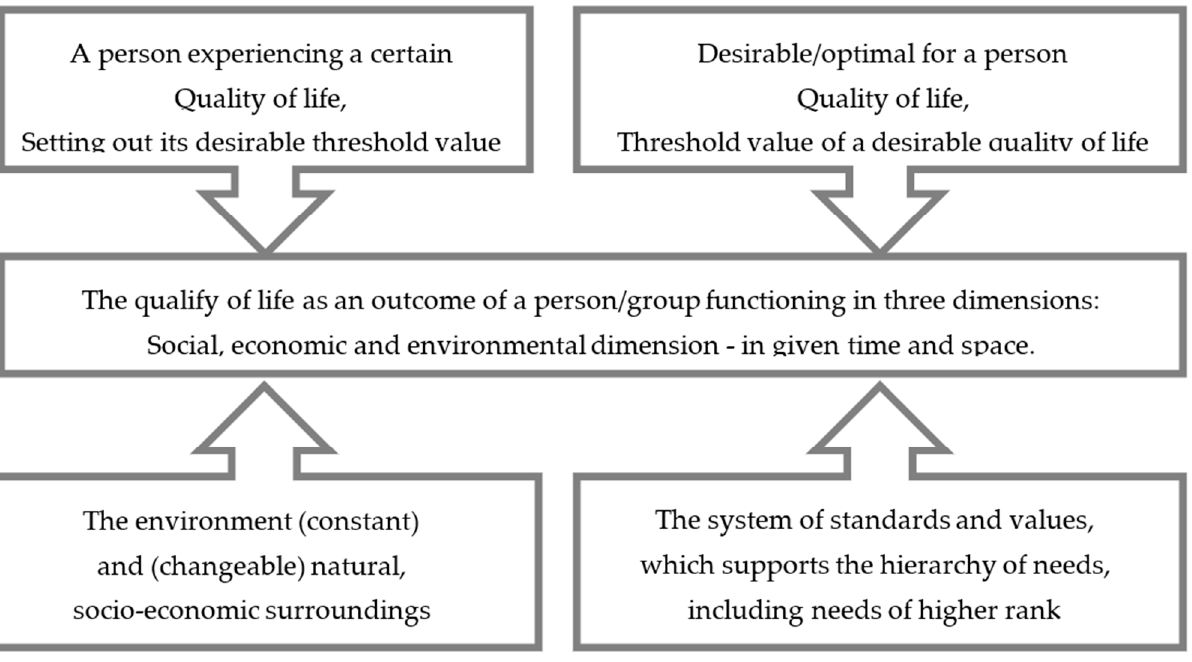
Figure 2. Quality of life across the urban policy objectives and measures. Source: own study.